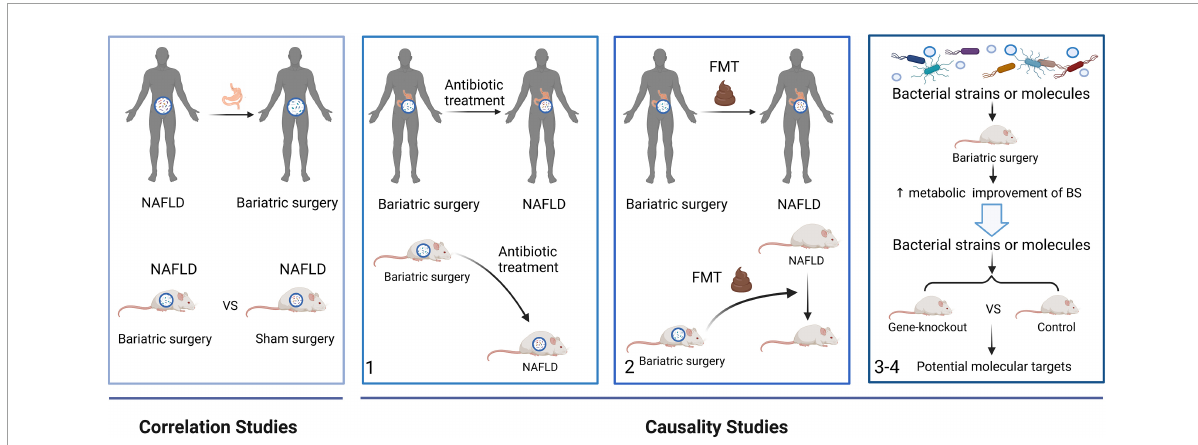
FIGURE3 A framework to study the role of the gut microbiome on the resolution of NAFLD after BS from correlation to causation. Correlations studies revealed the gut microbial alterations after BS in NAFLD patients and mice. In causality studies, firstly, antibiotic treatment attenuates the metabolic improvement of BS in NAFLD. Secondly, the metabolic benefits of BS are transferred using FMTs. Finally, microbial strains or molecules enhanced the effects of BS. Moreover, gene-knockout mice are used to find the molecular mechanism of the gut microbiome. FMT, fecal microbiota